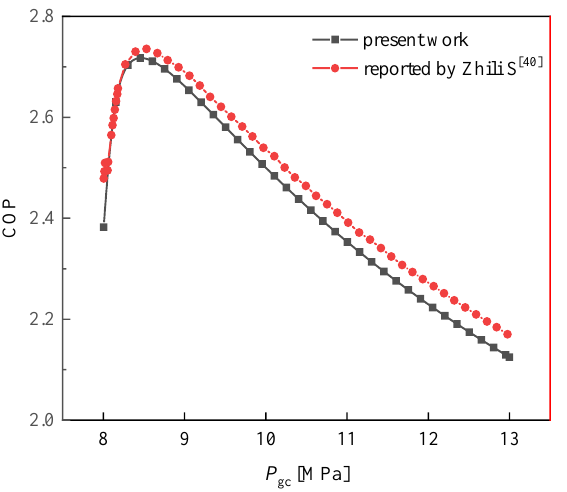
Figure 3. The comparison of COP reported by Zhili S [40] et al. and present modeling based on pressure of gas cooler. Table 2. Comparison of the present model results with the experimentally validated